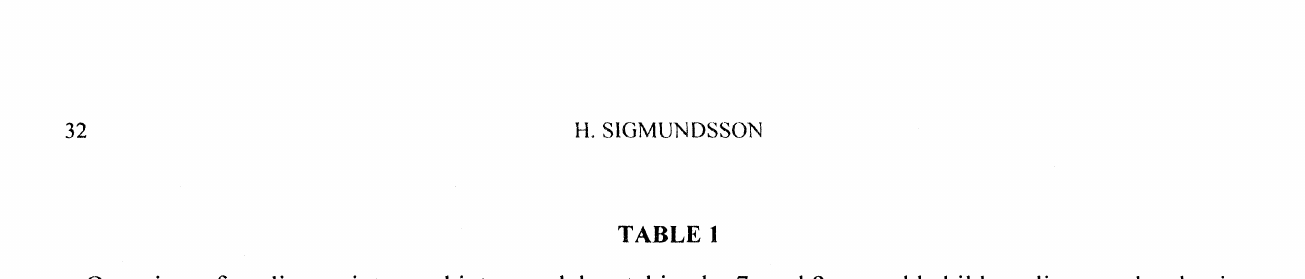
Overview of studies on inter-and intra-modal matching by 7- and 8-year old children diagnosed as having hand-eye co-ordination problems (HECP) and by a control group of children without such problems.